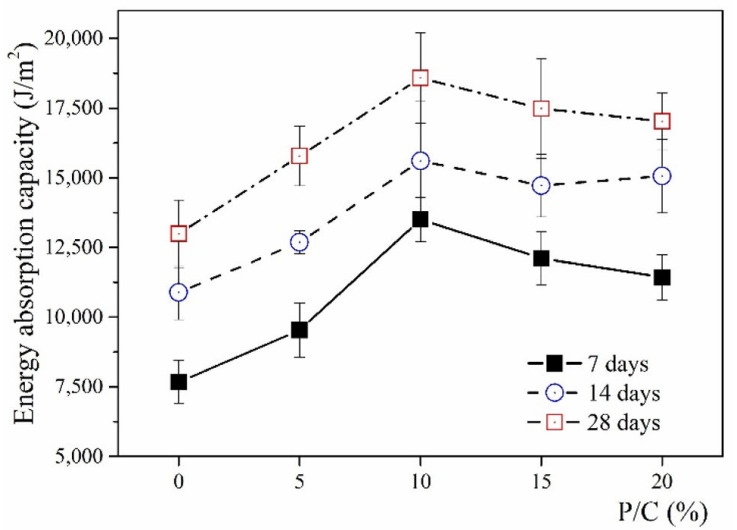
Figure 5. Influence of SBR latex on the energy absorption capacity of the cement paste at different ages of curing.